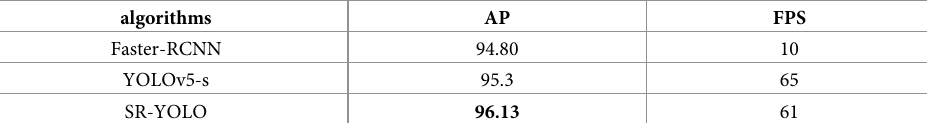
Table 9. Network test